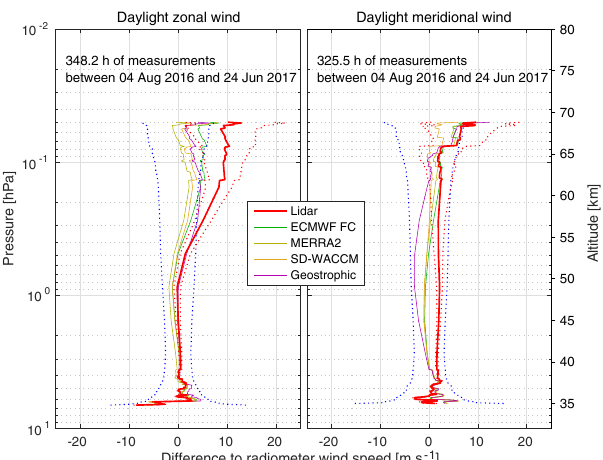
Figure 6. Mean difference of all convolved daytime zonal and meridional wind profiles from models, reanalyses, MLS geostrophic winds and the RMR lidar to the observations from WIRA recorded during the entire intercomparison campaign. The bands of random errors of the radiometer and the lidar observations are denoted by blue and red dotted lines, respectively. The discon- tinuities in the profiles visible at the upper and lowermost altitudes originate from the averaging over observations with different alti- tude coverage. Only data from the time period when both instru- ments were operated in their respective daylight mode have been considered.